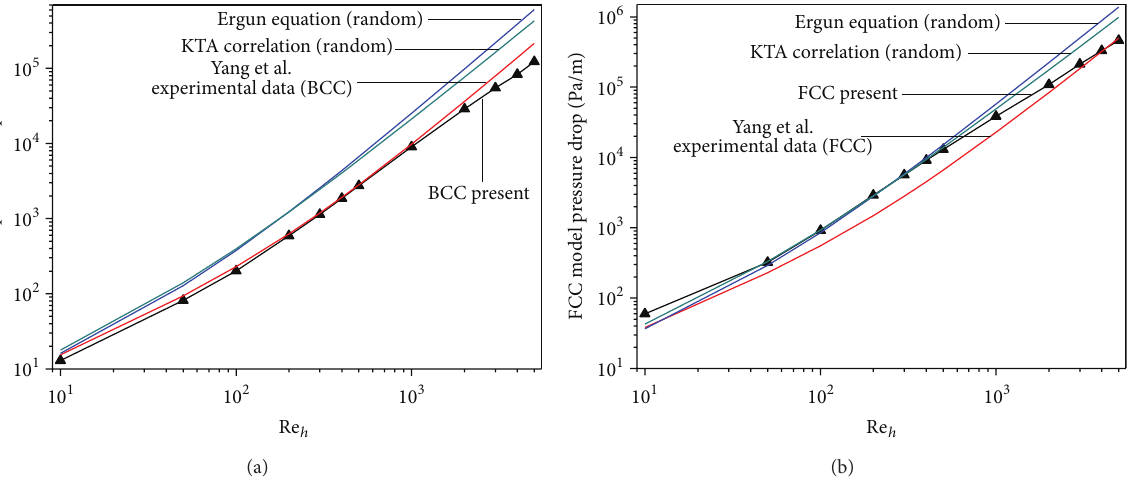
Figure 5: Pressure drop of BCC and FCC model.